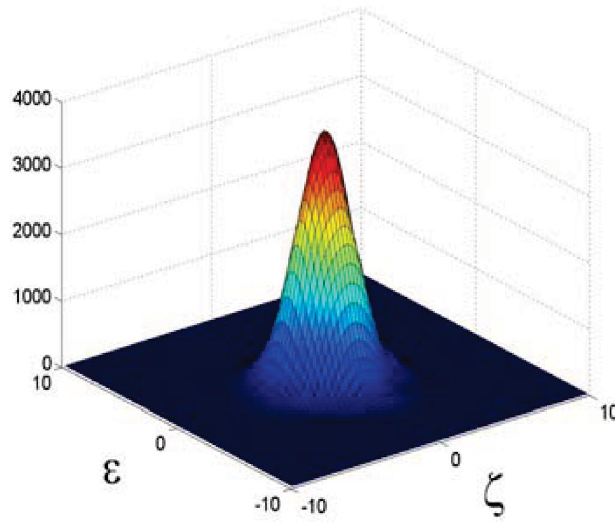
(3).FIG. 4. (Color) Percent error vs number of profiles for pillbox, Gaussian, Laguerre-Gaussian, and Hermite-Gaussian represen- tation for a theoretical shape given by Eq. (16), each profile is separated by 10 (cid:15) .